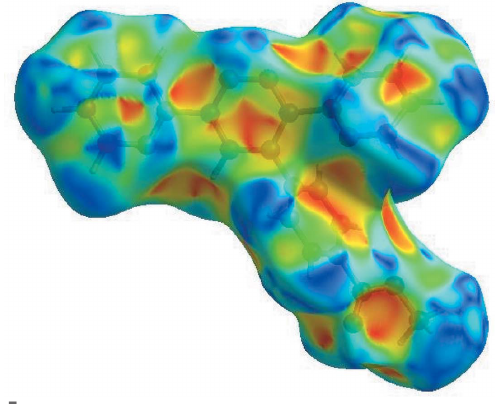
Figure 5 Hirshfeld surface of the title compound plotted over shape-index.